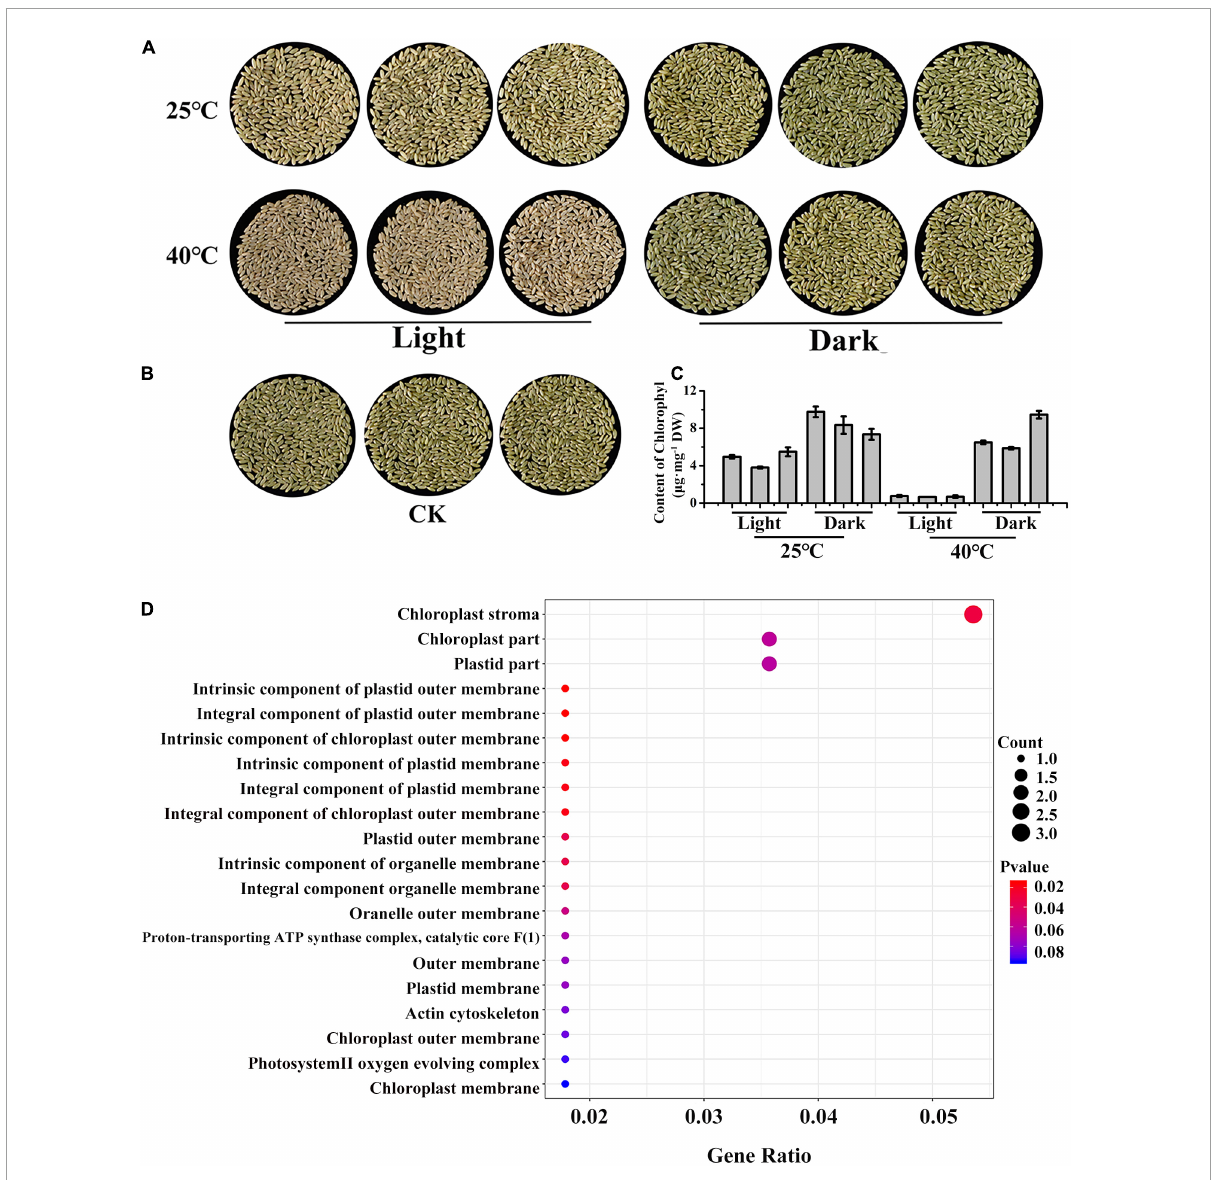
FIGURE4 LM8 pericarp colors and chlorophyll contents in response to light and temperature stress. (A,B) Pericarp colors after a treatment with 24-h light and 25/40 ◦ C temperature stress. (C) Chlorophyll contents under stress conditions. (D) Dot plot analysis of enriched GO terms in the cellular component category following an RNA-seq analysis of samples that underwent the 24-h light and 40 ◦ C